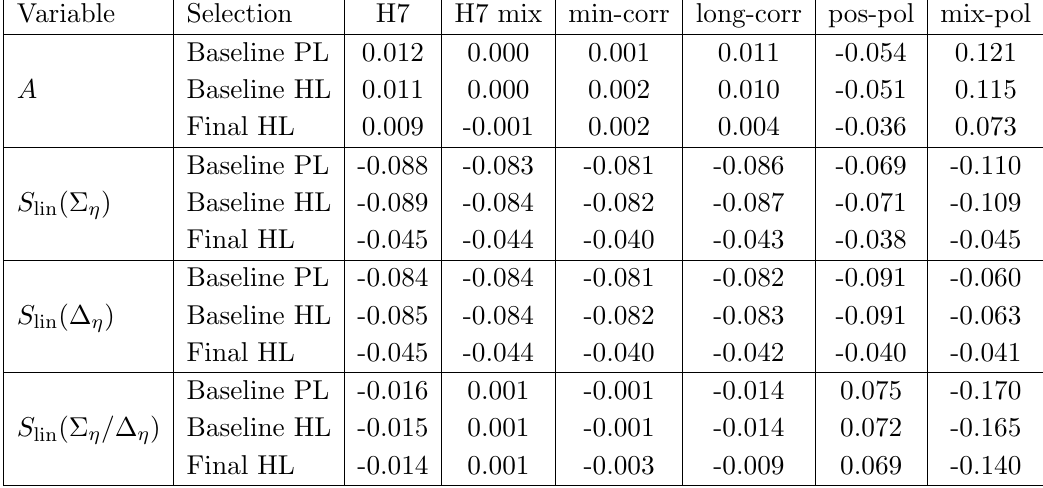
Table 2 . Results for the rapidity asymmetry A and slopes of linear (cid:12)t to three correlation sensitive observables. All three event selections are shown for all four observables to compare its evolution through the considered steps: transition from parton level (PL) to hadron level (HL) and transition to restrictive cuts labeled as Final